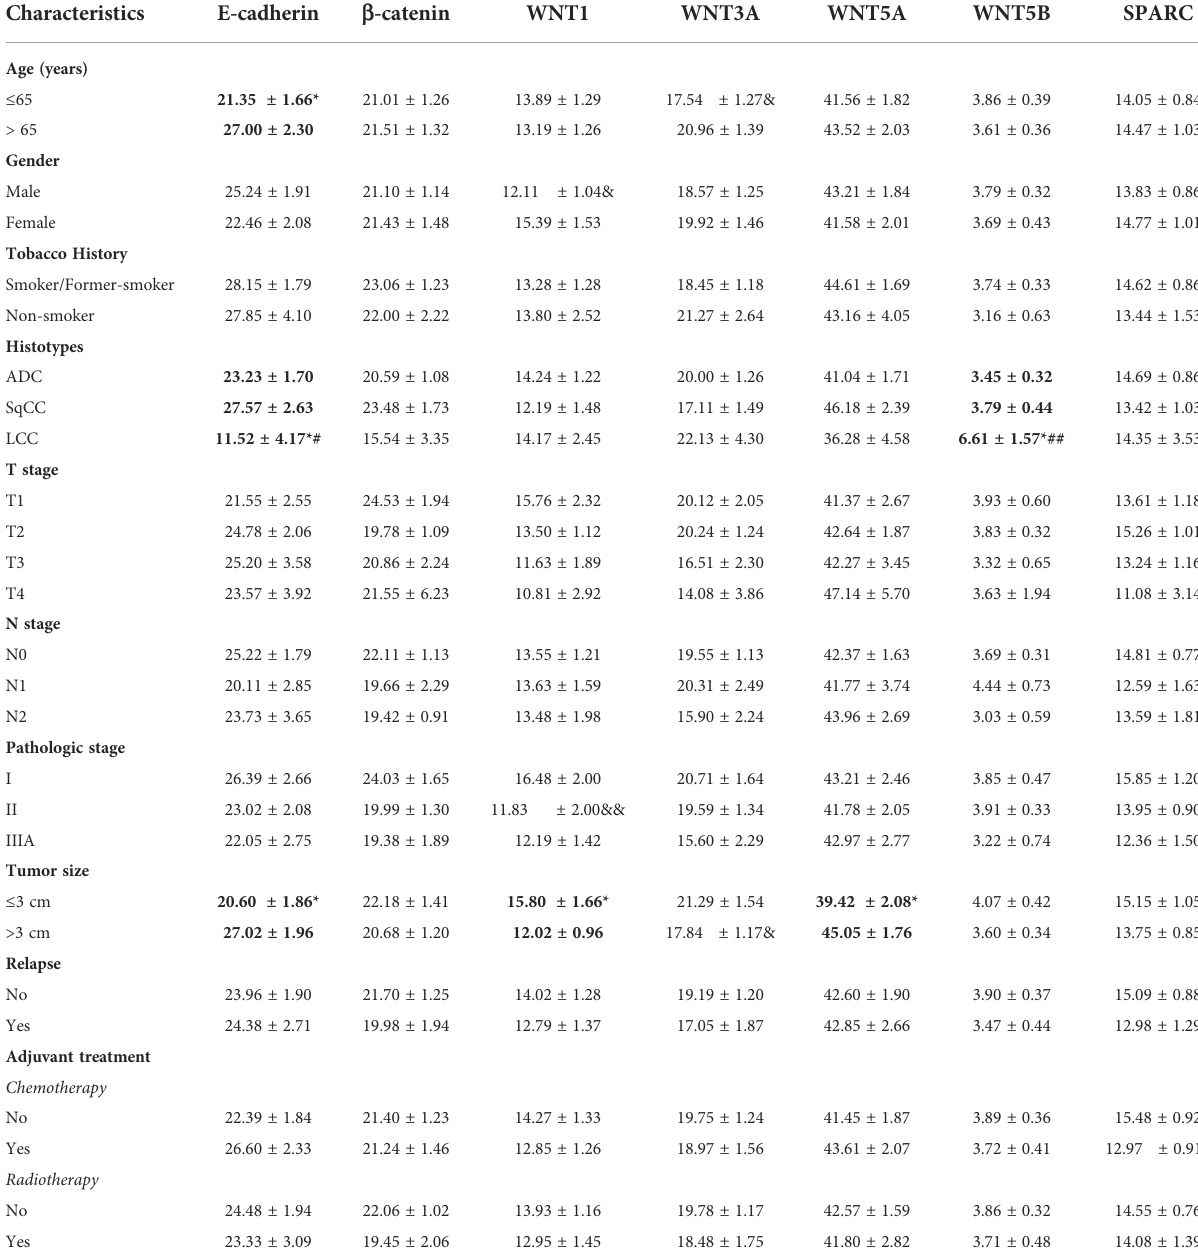
TABLE 2 Association between clinicopathologic characteristics and mean expression (% positive expression) of E-cadherin, b -catenin, WNTs signaling proteins, and SPARC ( t test and ANOVA, P<0.05). Characteristics E-cadherin b -catenin